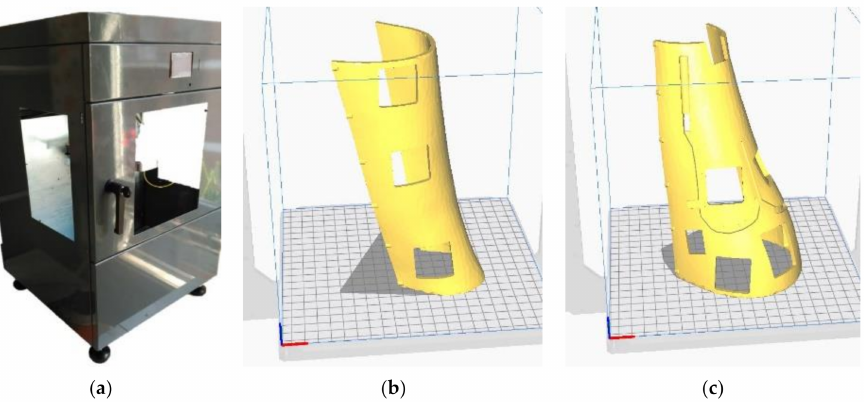
Figure 11. Total-Printer machine ( a ) and the two parts of the splint ready for printing ( b , c ).